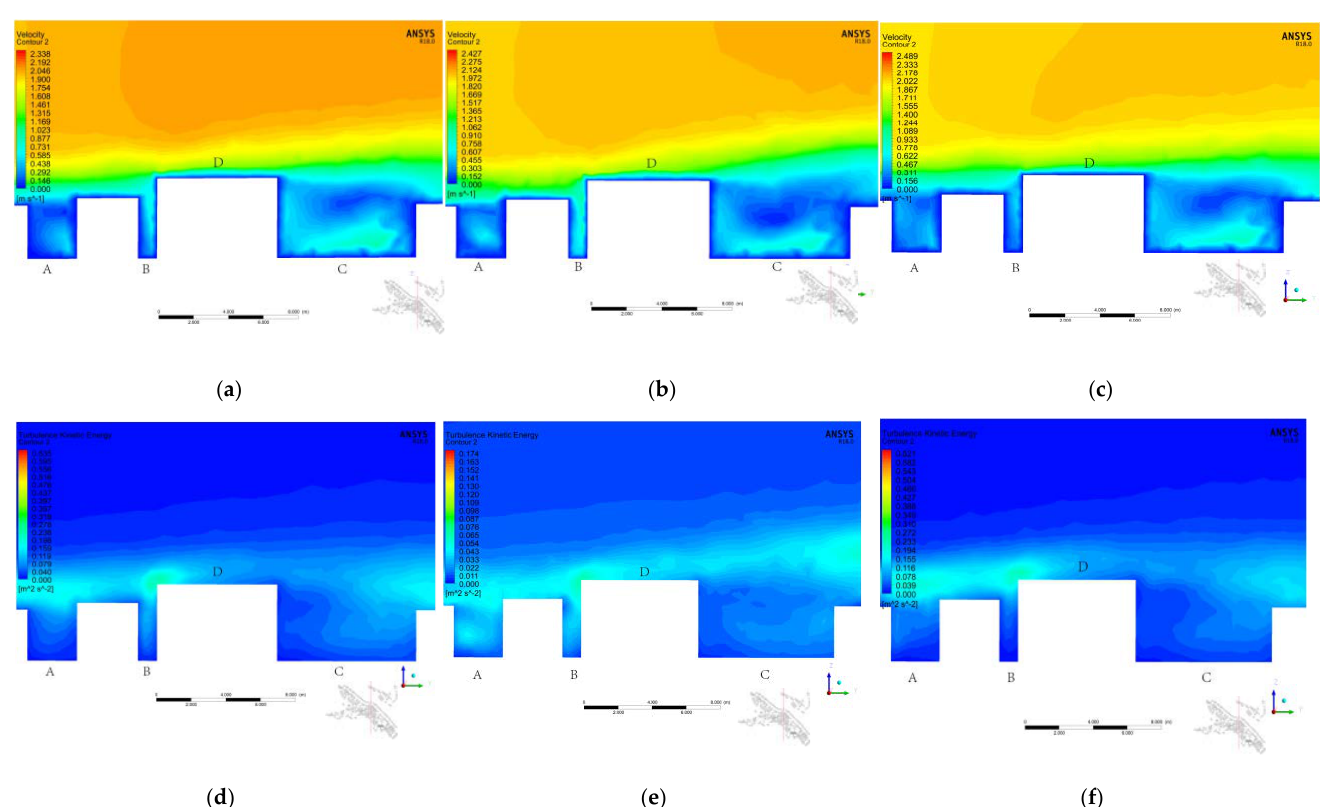
Figure 14. Local wind environment and turbulence intensity distribution in the vertical direction. ( a ) Local wind environ- ment distribution simulated by SKE in the vertical direction. ( b ) Local wind environment distribution simulated by SKE in the vertical direction. ( c ) Local wind environment distribution simulated by SKE in the vertical direction. ( d ) Local wind environment distribution simulated by SKE in the vertical direction. ( e ) Local wind environment distribution simulated by SKE in the vertical direction. ( f ) Local wind environment distribution simulated by SKE in the vertical direction.